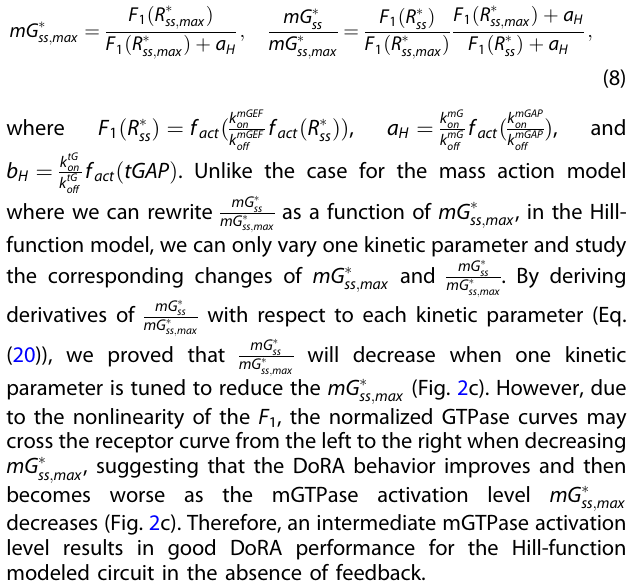
(denoted by on ; k tG ; k mGAP , with the on on on g , because the k R affects the on on